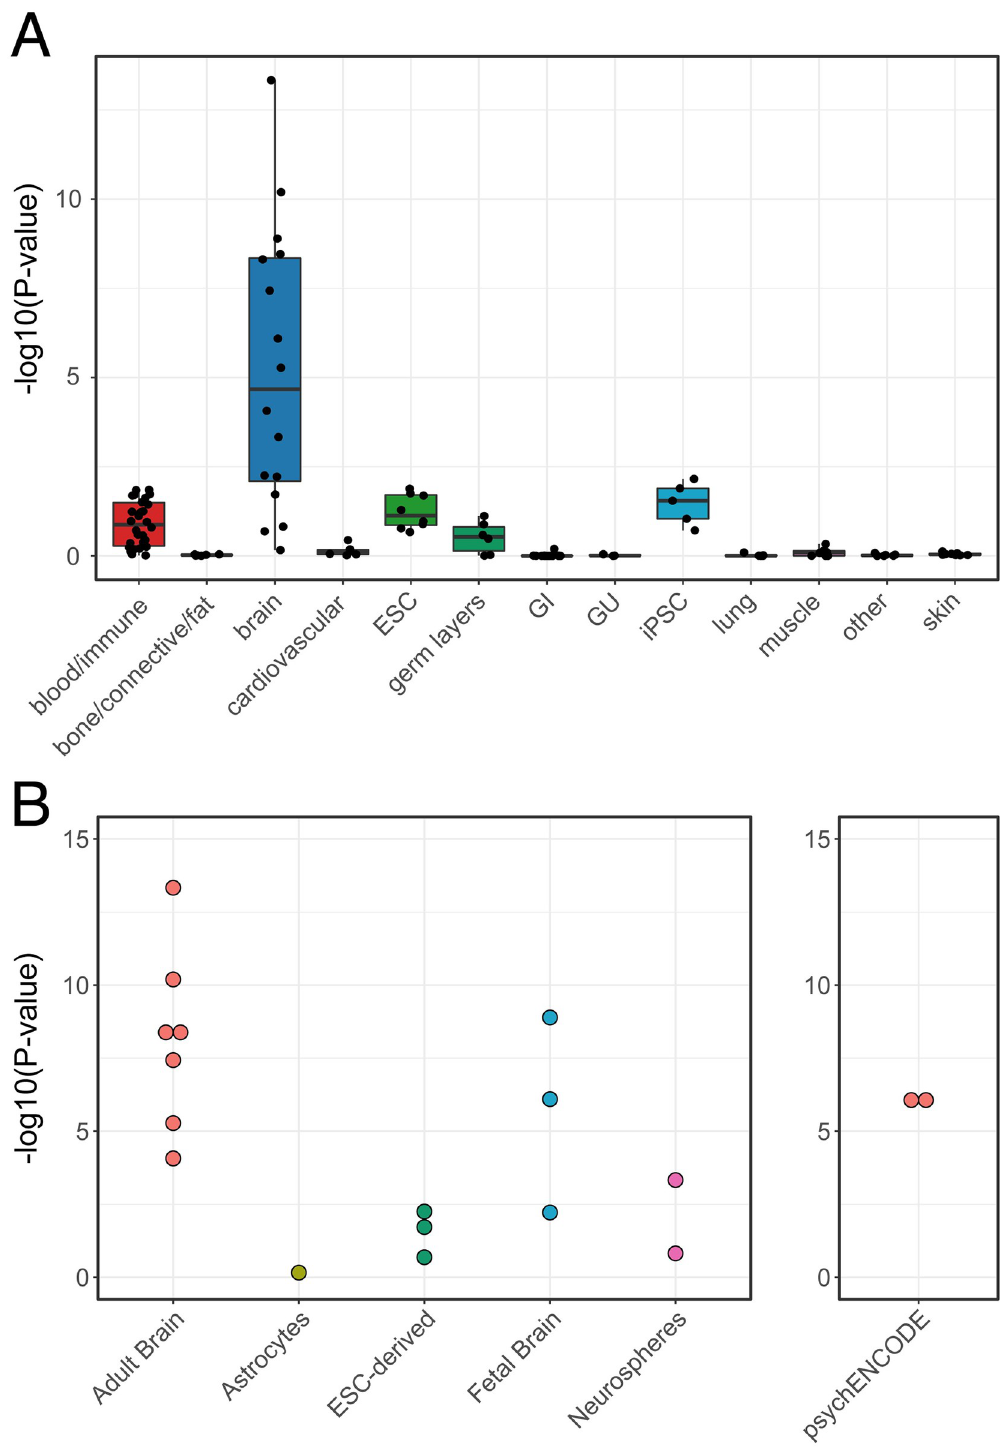
Fig 3. Genetic risk for schizophrenia is enriched in ChromHMM-derived brain enhancers. A) Partitioned heritability of enhancer annotations by tissue in schizophrenia. Brain enhancers are enriched for heritability in schizophrenia compared to other tissues. B) Partitioned heritability of individual brain samples. Adult brain enhancers had the most significant enrichment, followed by fetal brain enhancers.